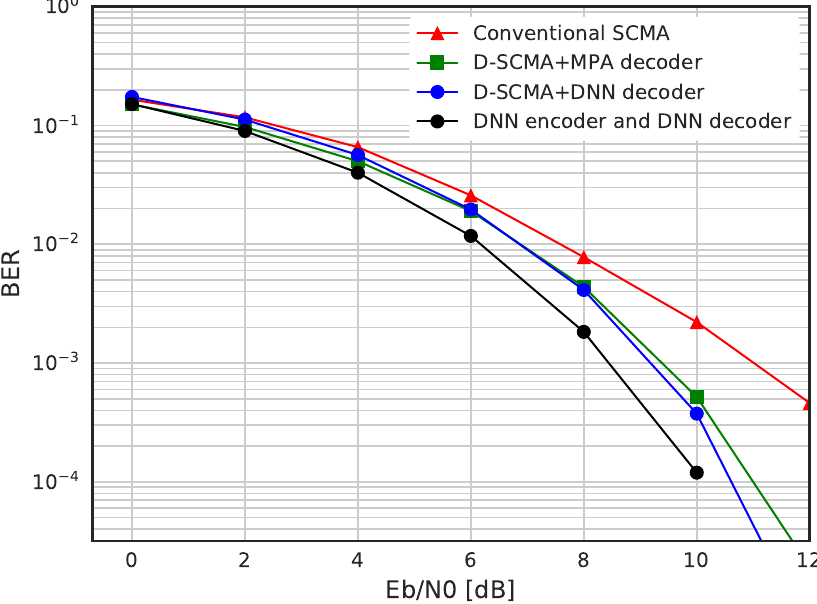
Figure 10. BER performance for conventional SCMA, D-SCMA and